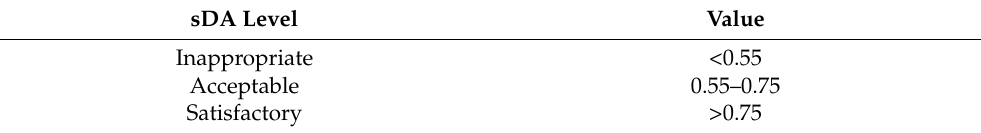
Table 7. sDA rating evaluation.